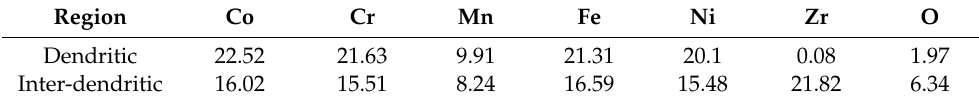
Table 6. Semi-quantitative analysis of the Zr-added alloy (atomic %) as obtained from EDS. Region Co Cr Mn Fe Ni Zr O Dendritic 22.52 21.63 9.91 21.31 20.1 0.08 1.97 Inter-dendritic 16.02